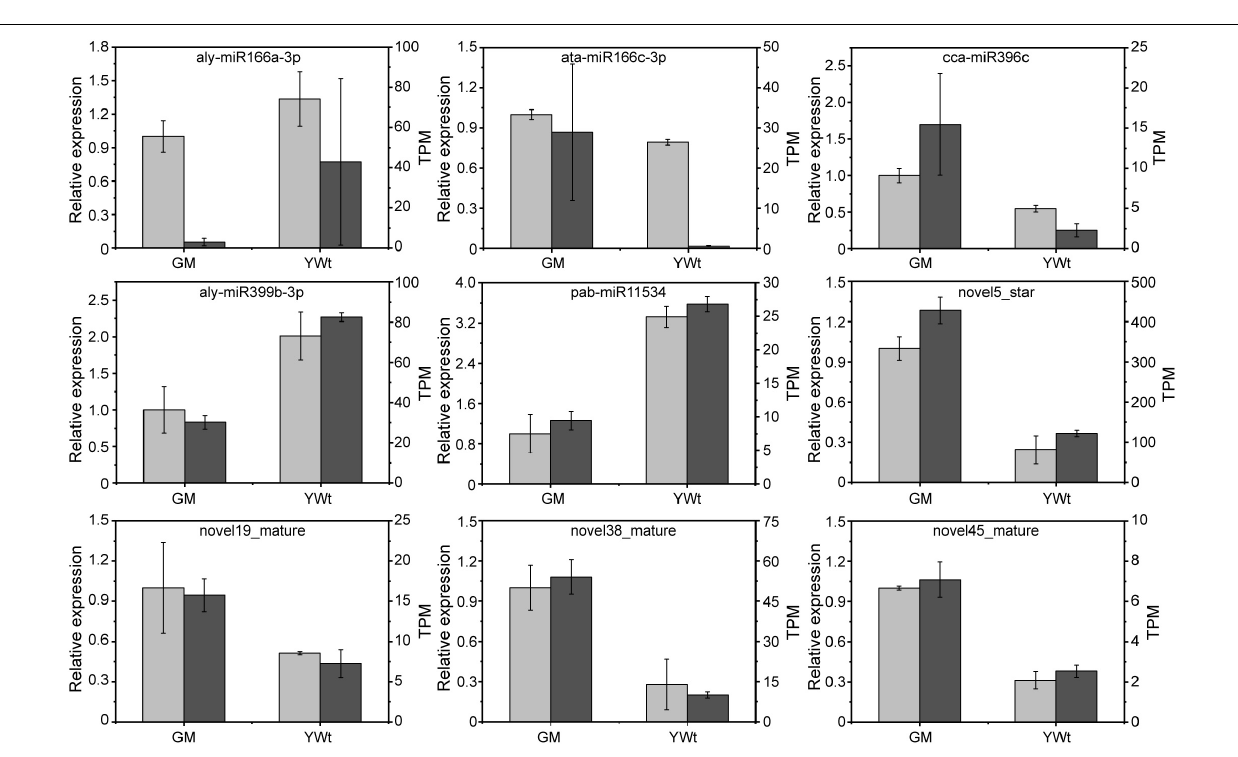
FIGURE 4 | Quantitative real-time PCR (qRT-PCR) validation of selected DERs. The x - and y -axes represent the sample (GM, evergreen mutant; YWt, yellowish-brown needles in winter) and the transcripts per kilobase million (TPM) or relative expression level, and the values shown represent the mean ± SD; n =